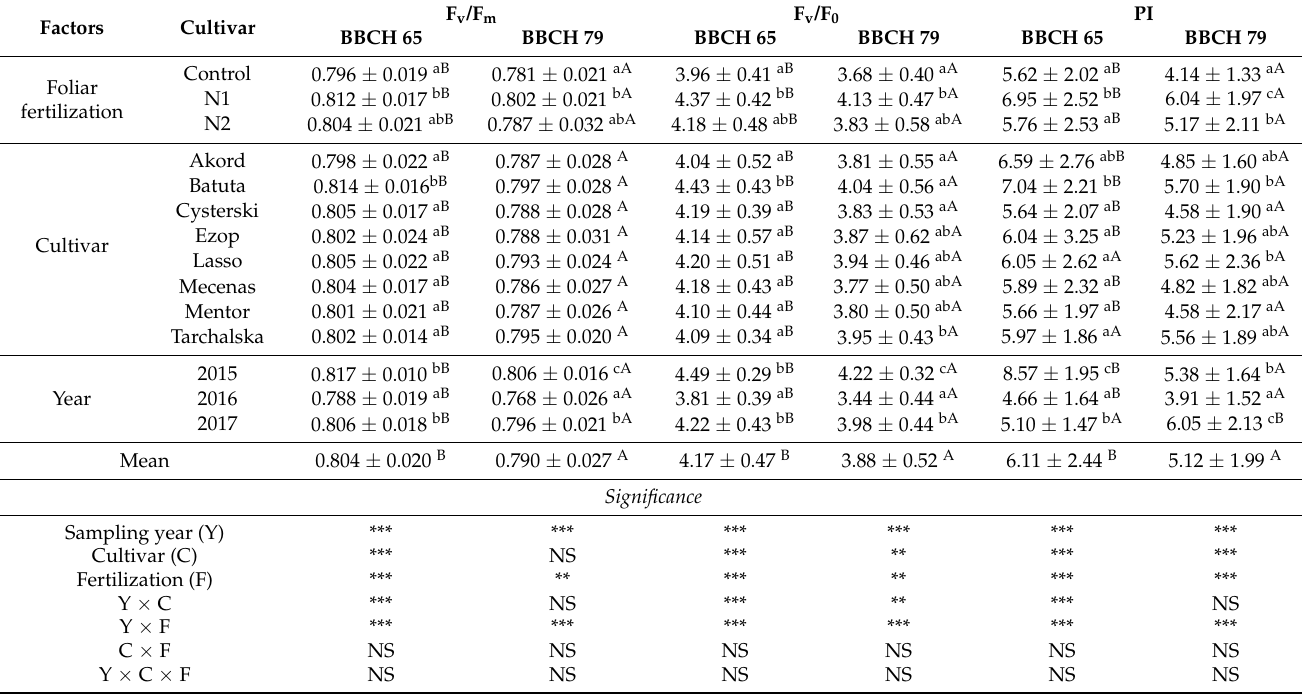
Table 2. Chl a fluorescence parameters in pea bracts at two growth stages (BBCH 65 and BBCH 97) according to fertilization (F; Control, N1, N2), cultivar (C; eight cultivars) and years of study (Y;